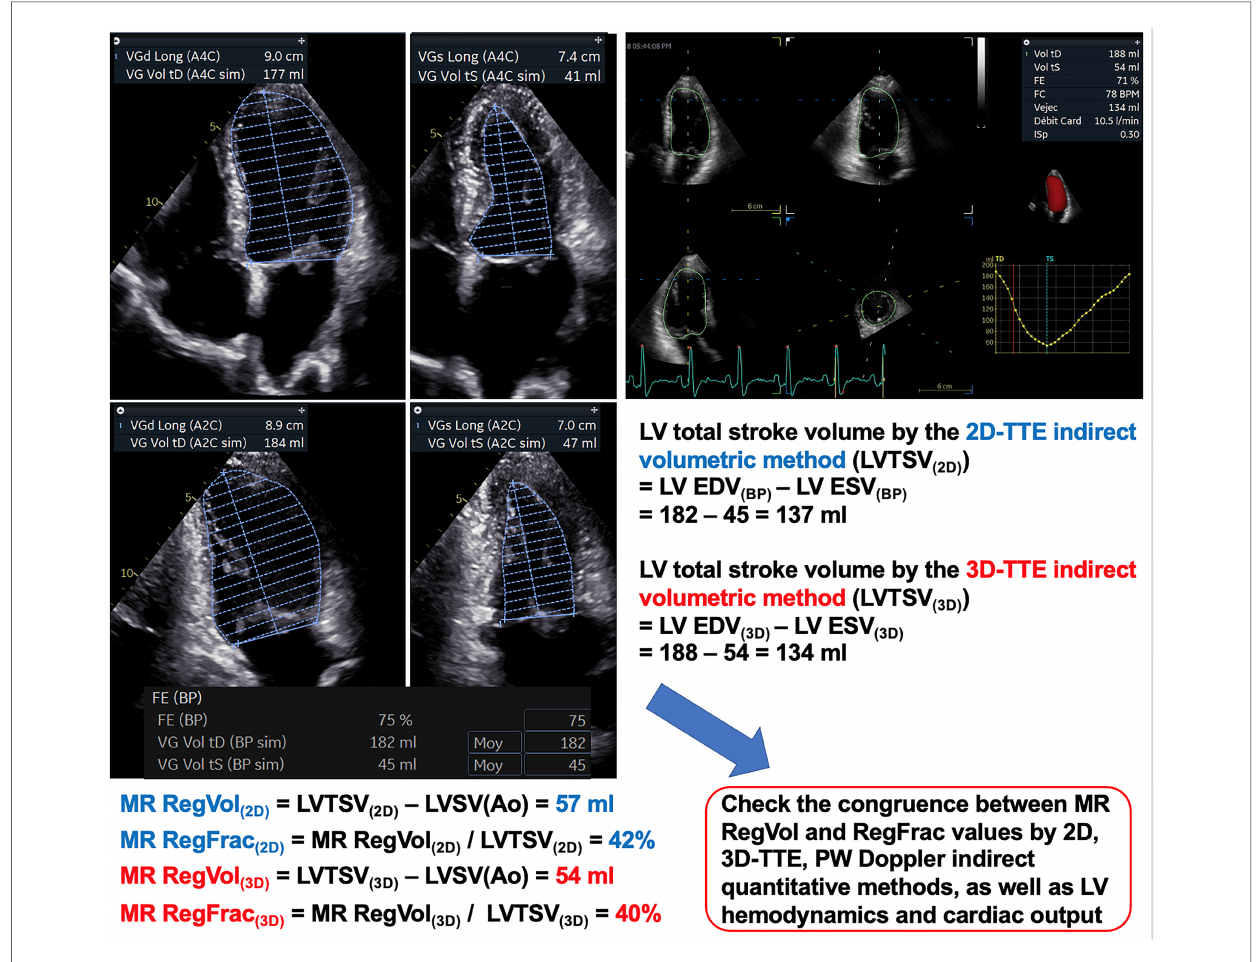
FIGURE 8 Indirect volumetric method. Same patient as Figures 5 , 7 . The LV total stroke volume is computed as the difference between LV end-diastolic and end- systolic volumes according to the 2D-biplane Simpson ’ s method [LVTSV (2D) ] or 3D-volumes [LVTSV (3D) ]. The LV borders should be traced at the interface between the LV cavity and the compacted myocardium, and not at the blood-tissue interface (that is at the tip of the trabeculation). The aortic systolic forward stroke volume is computed by the Doppler method (see Figure 7 ). The MR-RegVol (2D, 3D) is computed as the difference between the LVTSV (2D, 3D) and the LVSV(Ao). The MR-RegFrac (2D, 3D) is obtained by dividing the MR RegVol (2D, 3D) by the LVTSV (2D, 3D). The congruence between MR RegVol and RegFrac values obtained by the different indirect quantitative methods as well as LV hemodynamic and cardiac output should be carefully checked. Δ , diameter; BP, biplane; EDV, end-diastolic volume; ESV, end-systolic volume; LV, left ventricular/ventricle; LVSV(Ao), LV systolic aortic forward stroke volume by Doppler method; LVTSV (2D) , LV total stroke volume by 2D-indirect volumetric method; LVTSV (3D) , LV total stroke volume by 3D-indirect volumetric method; MR, mitral regurgitation; RegVol, regurgitant volume; RegFrac, regurgitant